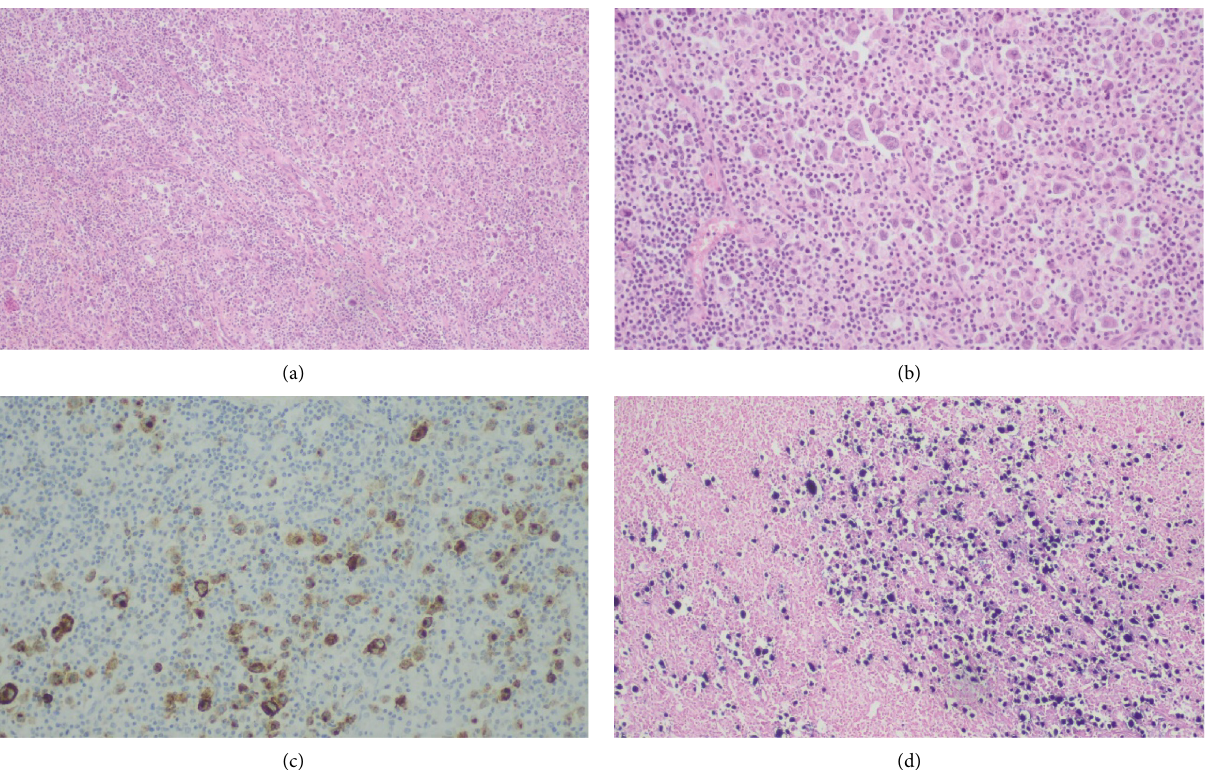
Figure 4: Histopathological examination of splenectomy specimen. Infiltration of the splenic tissue by large pleomorphic neoplastic cells resembling HRS cells: (a) H&E stain, 100x magnification; b) H&E stain, 200x magnification]. These cells were positive for CD30 (c) and EBER